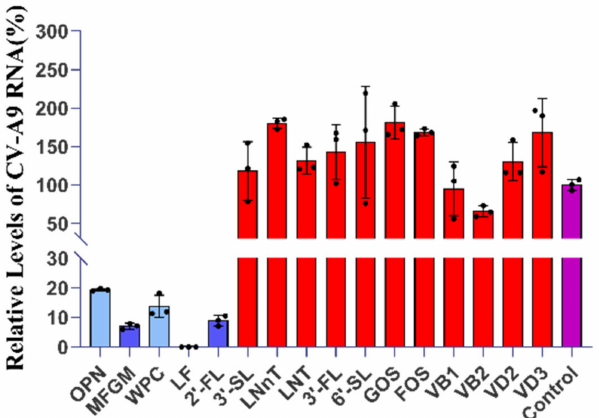
Figure 1. Hits of anti-CV-A9 drug screening from 16 breast milk ingredients. A total of 5 hits (MFGM, WPC, 2’-FL, LF, and OPN) were found with significant inhibition against CV-A9 indicated by the blue bars; OPN and WPC with an inhibition rate of <90% were indicated in light blue. Ineffective drugs are represented by red bars and control by purple. The Y-axis represent the relative viral load. The relative viral mRNA expression and inhibition rate were calculated based on the Ct value, denoted by B and I, respectively. The formula is as follows: A = expression level of CV- A9 mRNA/GAPDH mRNA = 2 (CtGAPDH − CtCV-A9) ; B ingredient (%) = (A ingredient /A control ) × 100%; I ingredient (%) = 1 − (B ingredient − B control ) × 100%. Data represent the mean of the three replicate results. Error bars represent ± 1 SD, and the experiments were repeated at least